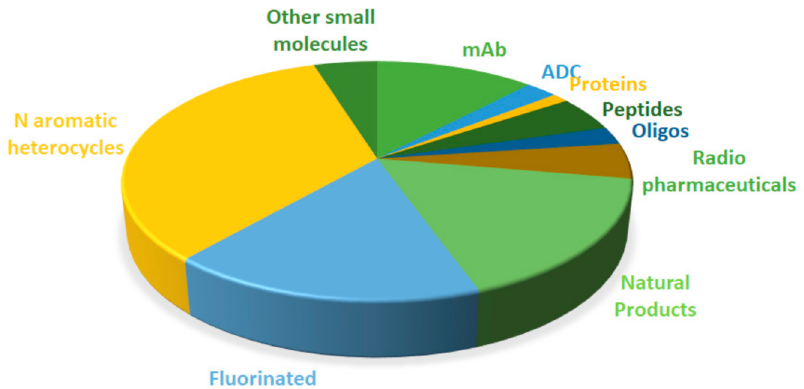
Figure 16. Drugs approved by the FDA in 2020 classified on the basis of their chemical structure (drugs can belong to two distinct